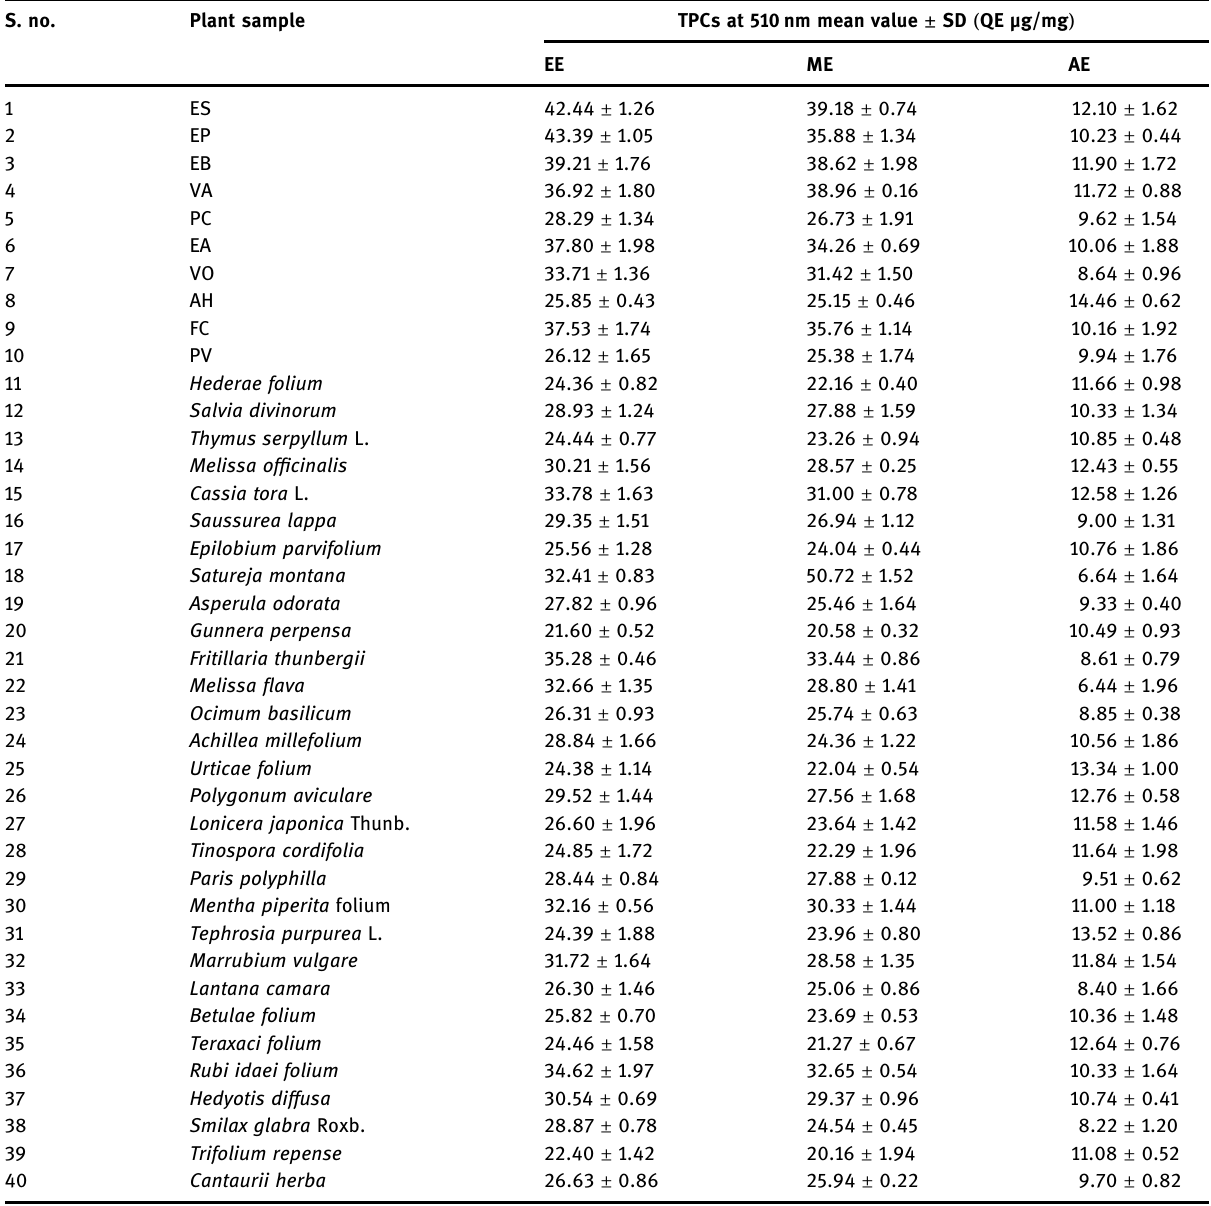
Table 3: TFCs found in various medicinal plants at 510 nm S. no. Plant